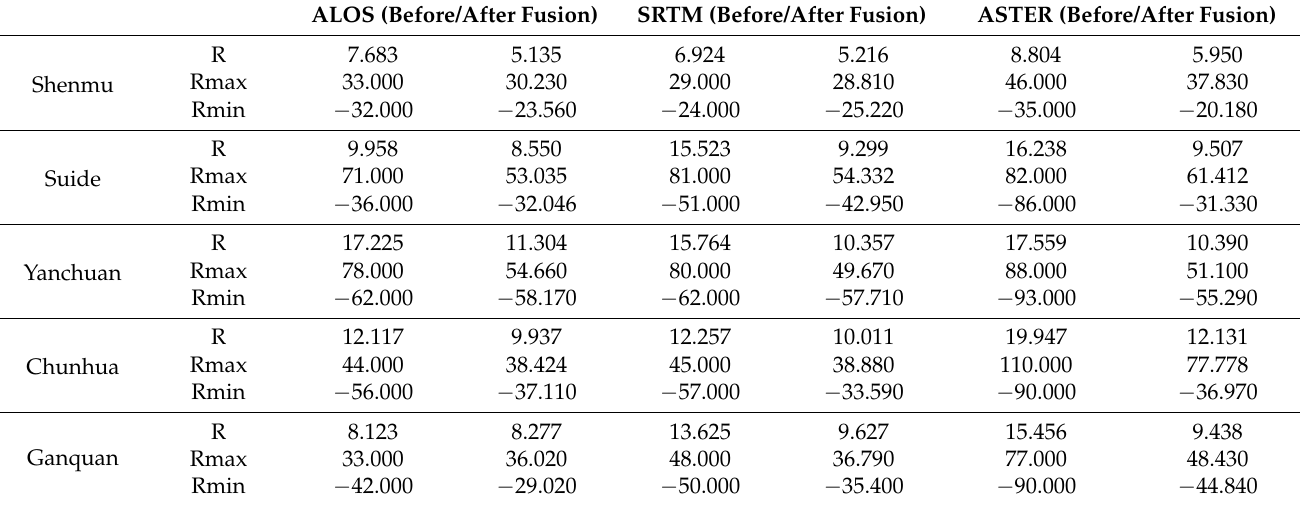
Table 6. Error statistical values before and after embedding feature points (unit: m). ALOS (Before/After Fusion) SRTM (Before/After Fusion) ASTER (Before/After